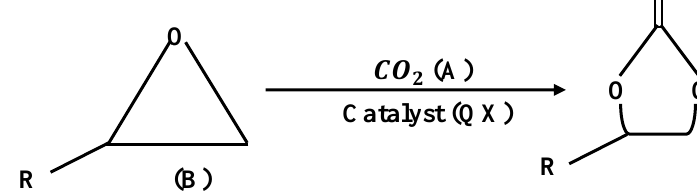
Figure 2. The overall reaction between CO 2 and